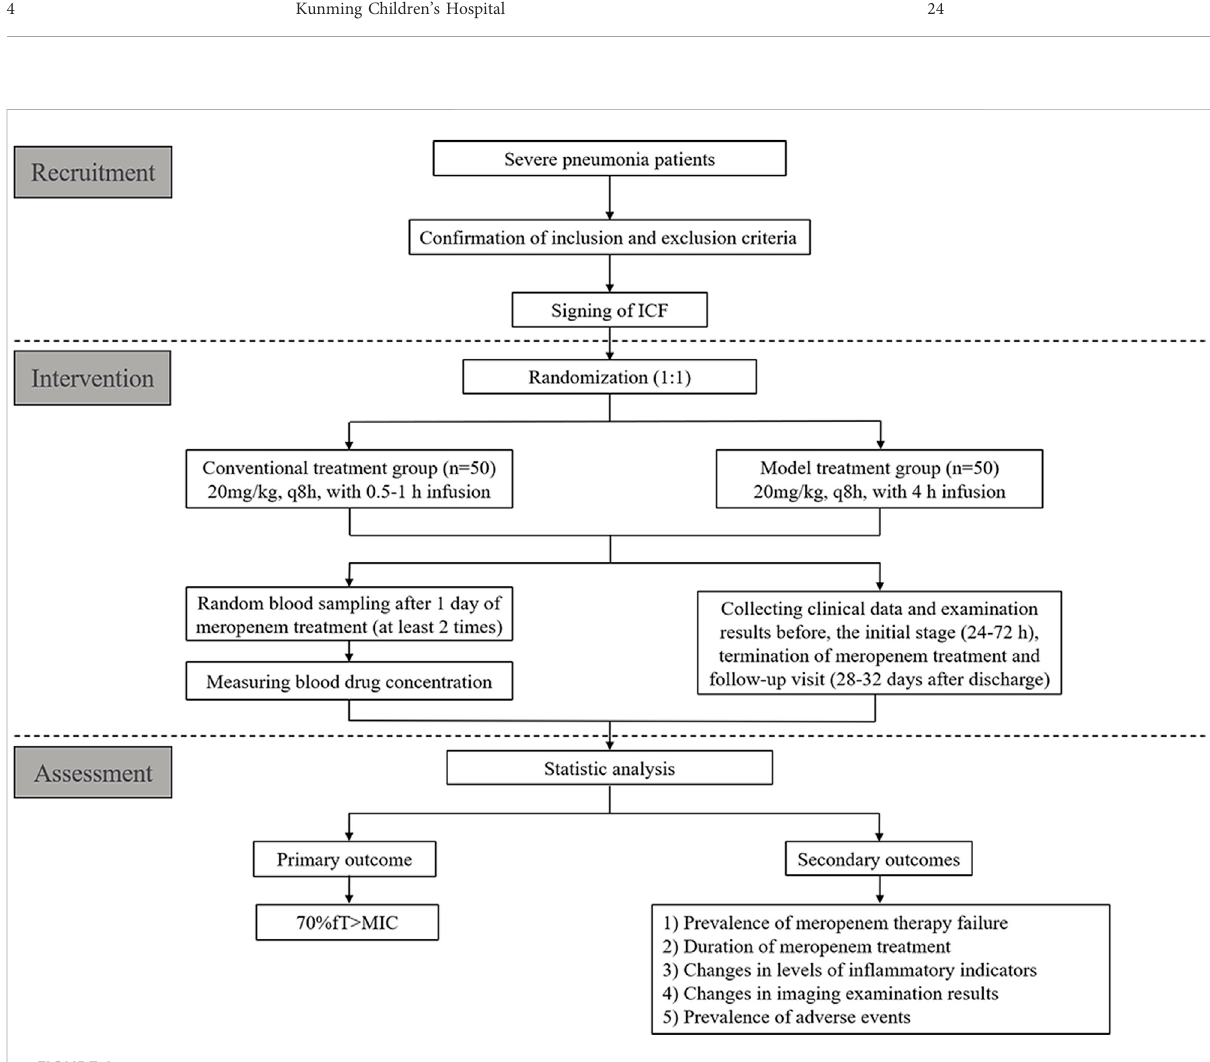
FIGURE 1 The schematic diagram of the RCT